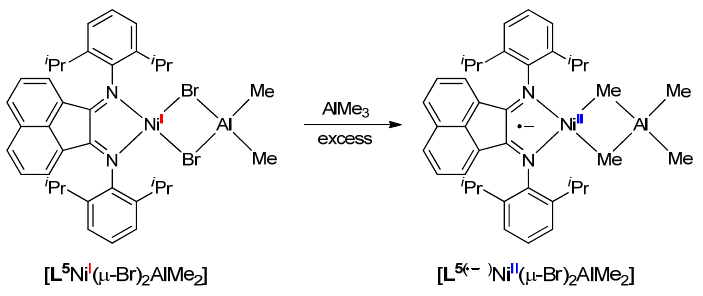
Figure 2. Structures of [( L 4 Ni I Br) 2 MgBr 2 (THF) 2 ] and [( L 4 Ni I Br) 2 ]. In 2015, Gao and Mu and co-workers isolated a neutral heterobinuclear nickel(I) com- plex [ L 5 Ni I ( μ -Br) 2 AlMe 2 ] from the L 5 Ni II Br 2 /AlMe 3 reaction mixture (Scheme 4, Al/Ni = 4/1) [31]. When activated with excess AlMe 3 or MAO, [ L 5 Ni I ( μ -Br) 2 AlMe 2 ] displayed high eth-